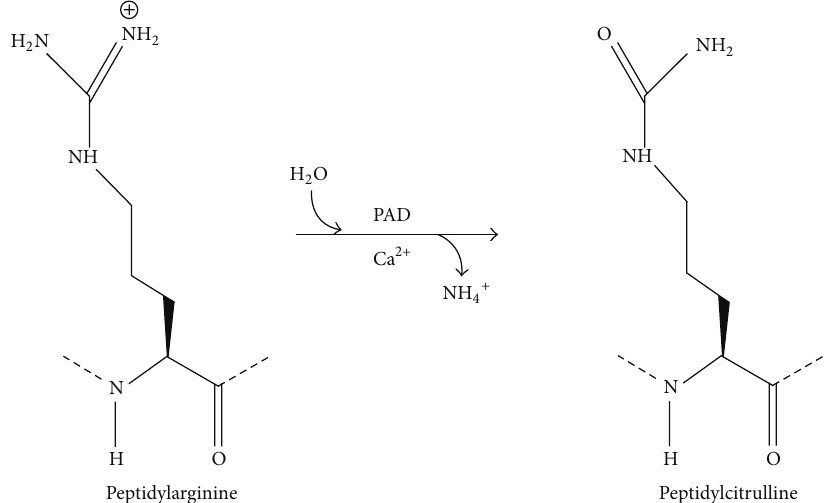
Figure 2: Biochemical process that occurs in protein citrullination